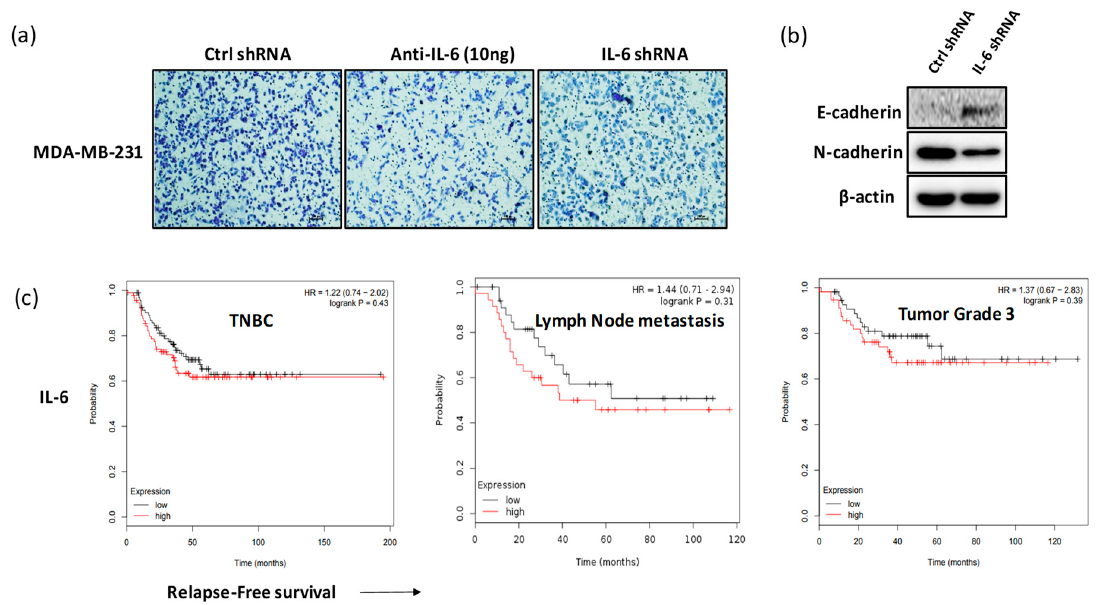
Figure 4. Blockade of IL-6 expression inhibits invasion and metastasis factors in MDA-MB-231 cells. MDA-MB-231 cells were seeded at a density of 2 × 10 5 cells / mL in a transwell and treated with anti-IL-6 antibody or IL-6 shRNA. After 12 h of incubation, cells were stained with crystal violet dye for invasion assay and cell lysates were harvested for western blotting. ( a ) Invasive capability of MDA-MB-231 cells (scale value is 100px). ( b ) Expression of E-cadherin and N-cadherin proteins. ( c ) Meta-analysis-based biomarker assessment with Kaplan–Meier Plotter showed a negative correlation between the blood level of IL-6 and relapse-free survival in patients with Triple-negative breast cancer (TNBC).